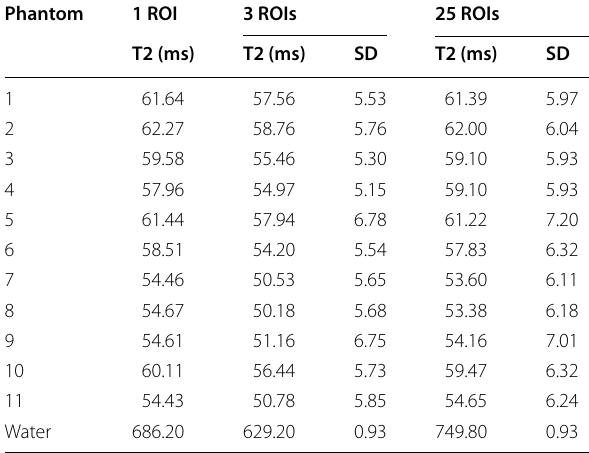
Table 9 T2 values of all agar gel phantoms at TP2